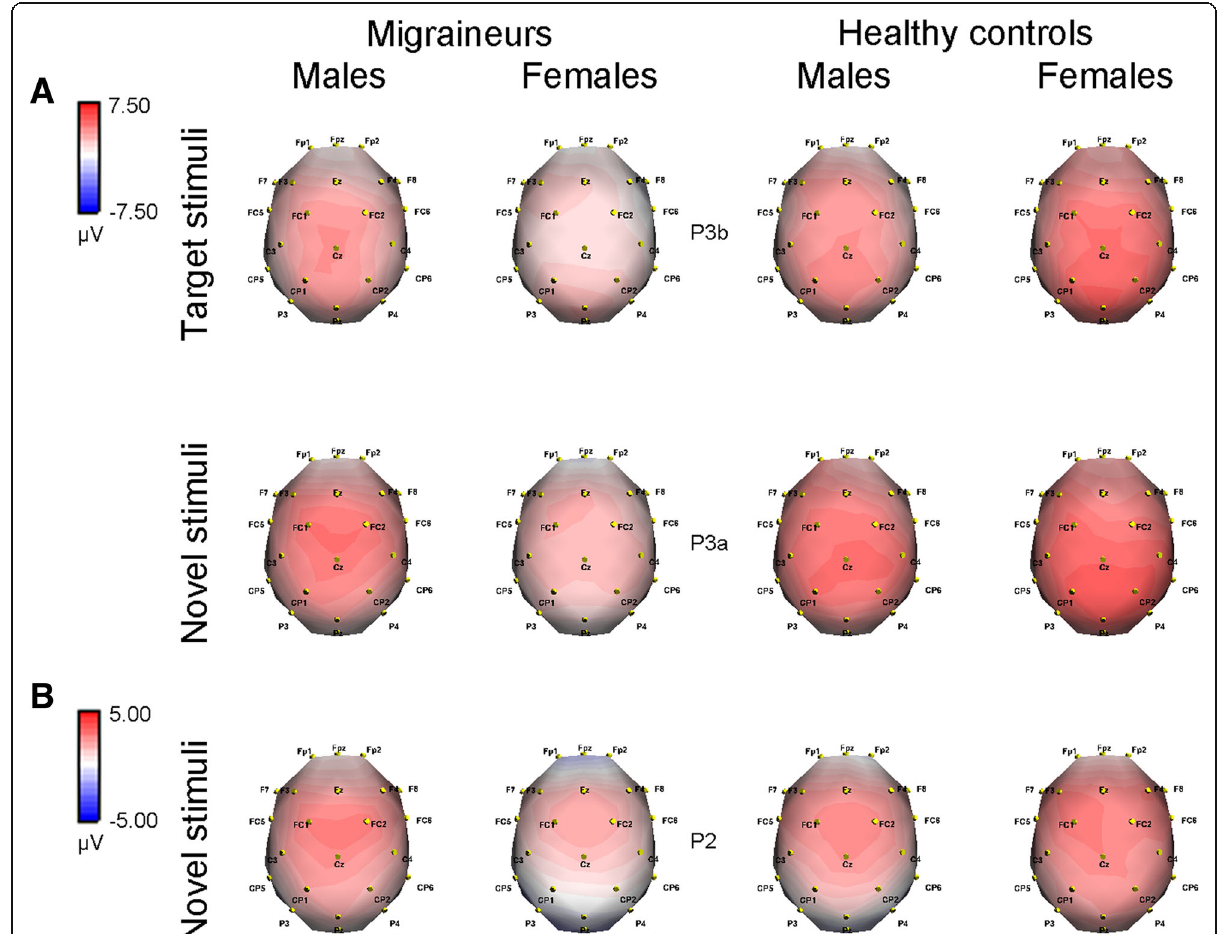
Fig. 2 Topographical voltage distributions of original ERP components in migraineurs and healthy controls, respectively. a P3 elicited by different stimuli: target stimuli (P3b) at 410 – 425 ms and novel stimuli (P3a) at 390 – 415 ms; ( b ) P2 elicited by novel stimuli at 170 – 185 ms. Red color denotes a positive and blue color a negative